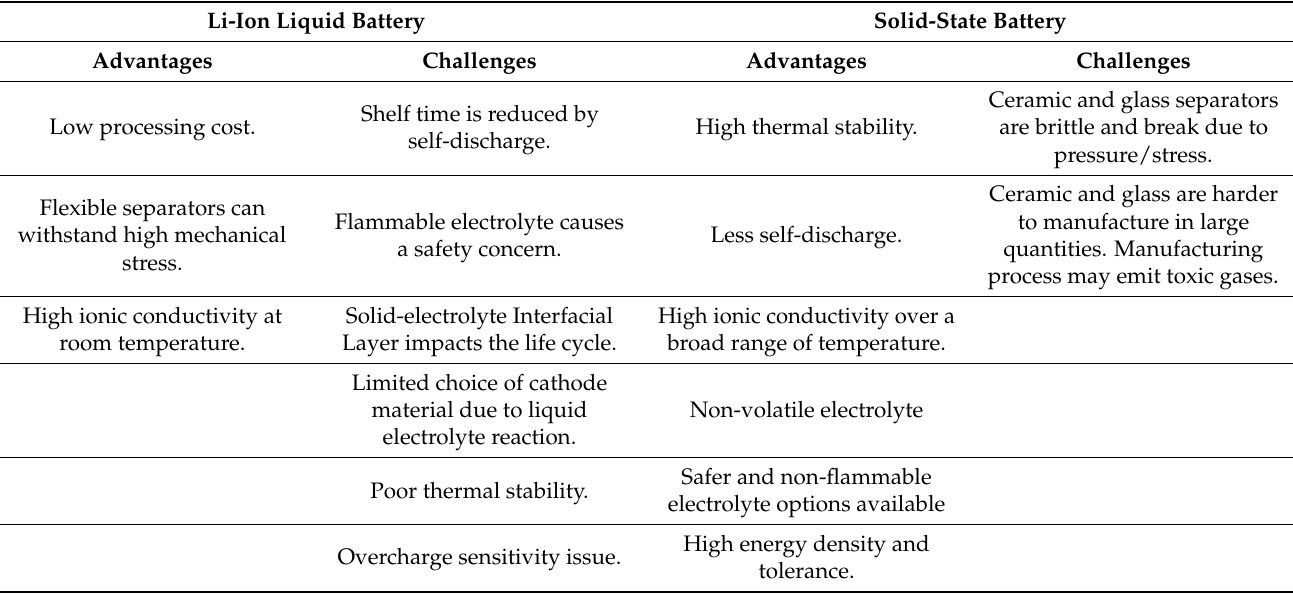
Table 4. Advantages and challenges of Li-ion battery versus solid-state battery